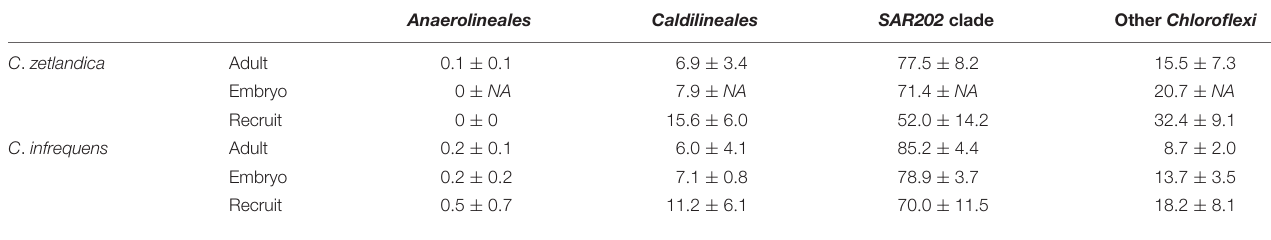
TABLE 1 | Average relative abundances of Chloroflexi ( Anaerolinae , Caldilineae , SAR202 , others) as determined by 16S amplicon sequencing. mean, and standard deviation per group are indicated. Anaerolineales Caldilineales SAR202 clade Other